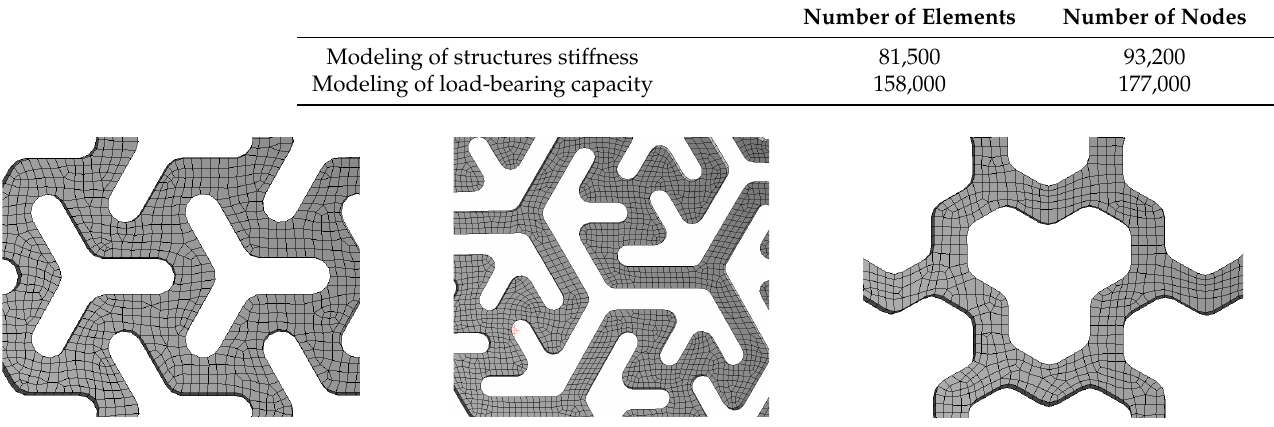
Figure 5. Visualization of the detail of the finite element mesh (specimen A— left , specimen B— middle and specimen C— right